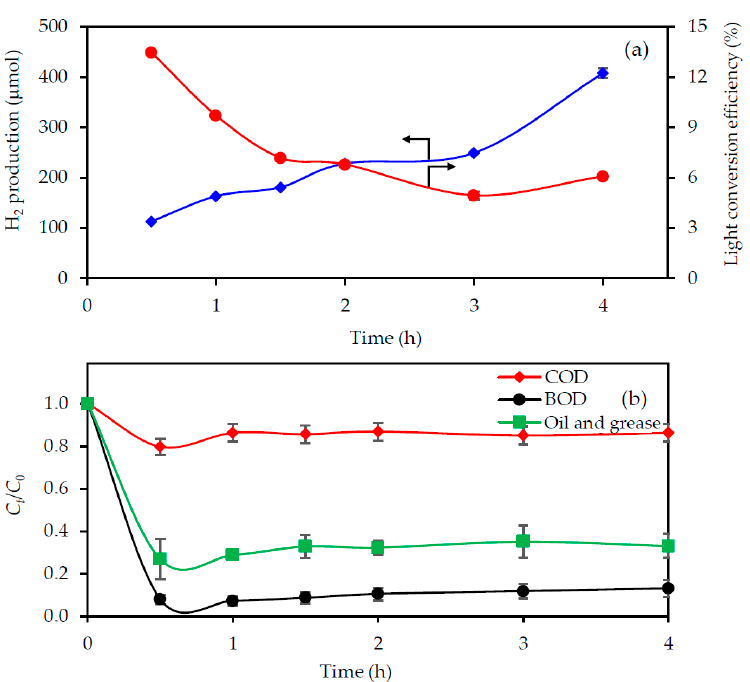
Figure 7. Effect of the reaction time on the level of ( a ) H 2 production with light conversion efficiency and ( b ) pollutant removal from the 3.3-fold diluted acid-pretreated biodiesel wastewater with an initial pH of 6.0 using a photocatalyst loading of 4.0 g/L and UV light intensity of 4.79 mW/cm 2 .